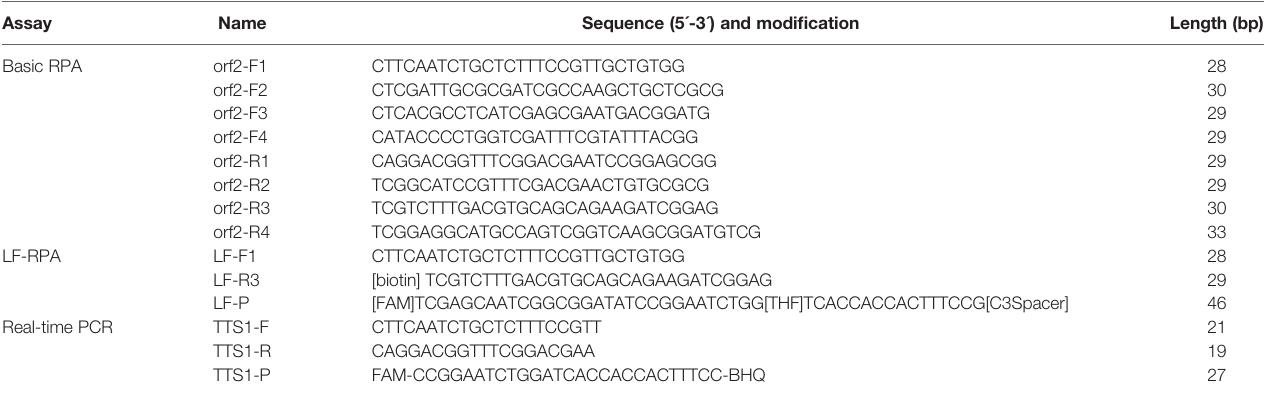
TABLE 1 | Primers and probe used in the present study.